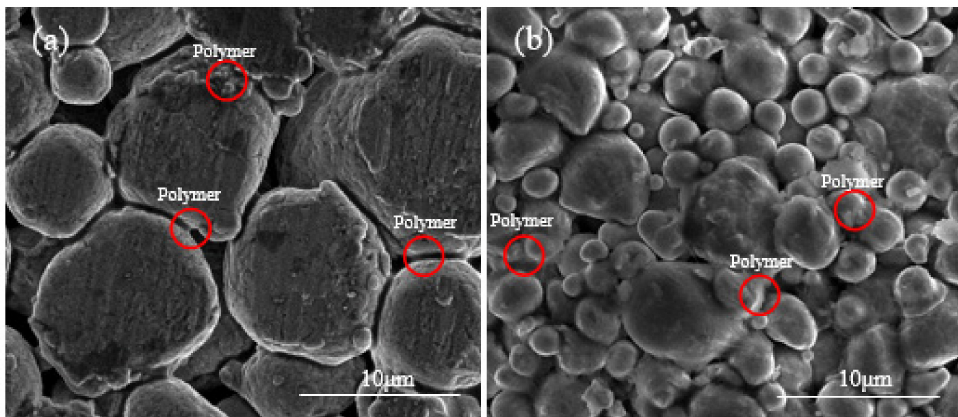
Figure 5. SEM images display the morphology of the specimens. ( a ) Compressed Al7075 sample. ( b ) Washed FDM 17-4 steel sample.